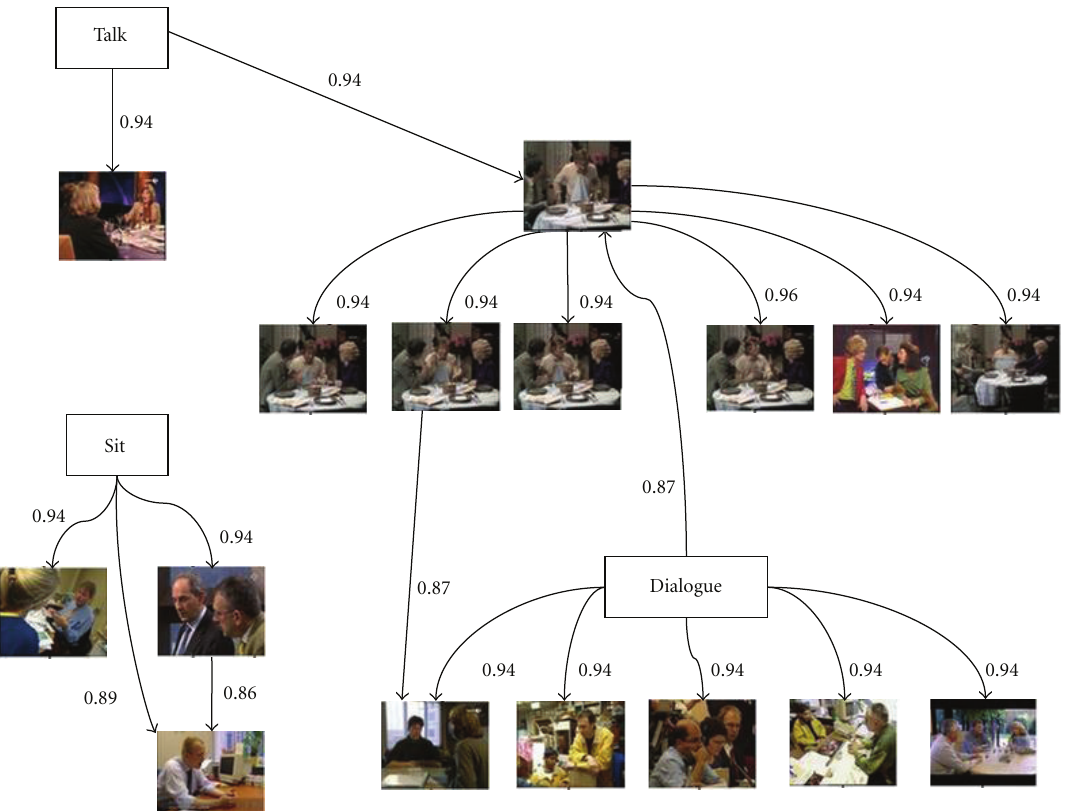
Figure 5: Weighted graph after processing the action graph of Figure